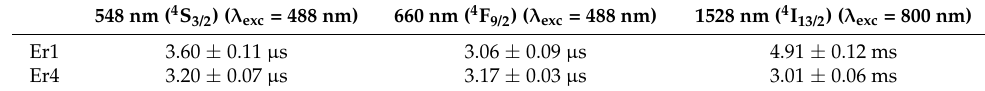
Figure 2. Room temperature emission spectra of the Er-doped aluminosilicate glasses with 1 wt% and 4 wt% under excitation at 488 nm. Table 2. Lifetimes at room temperature of the 4 S 3/2 and 4 F 9/2 levels obtained under excitation at 488 nm and 4 I 13/2 levels obtained under excitation at 800 nm.